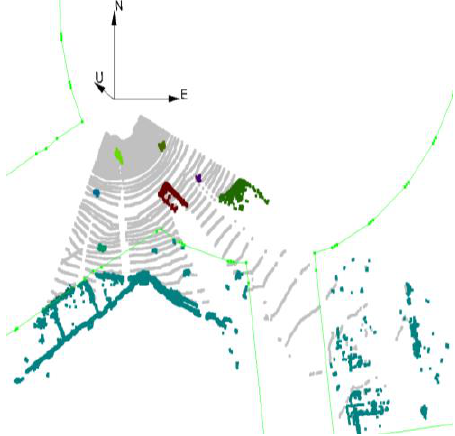
Figure 4. Clusters in the scene are calculated based on Euclidean